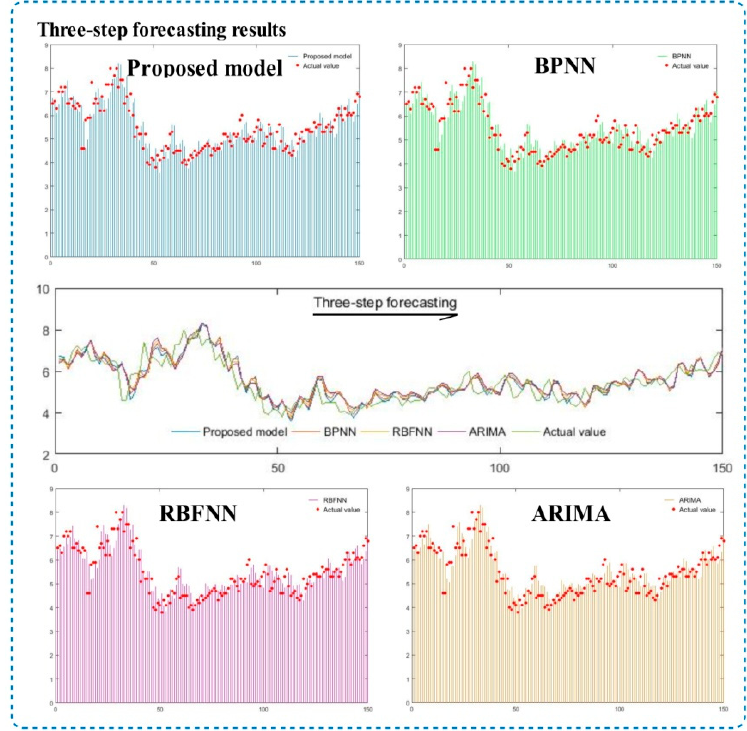
Figure 7. Three-step forecasting results of the proposed model and other traditional models (BP RBF ARIMA).